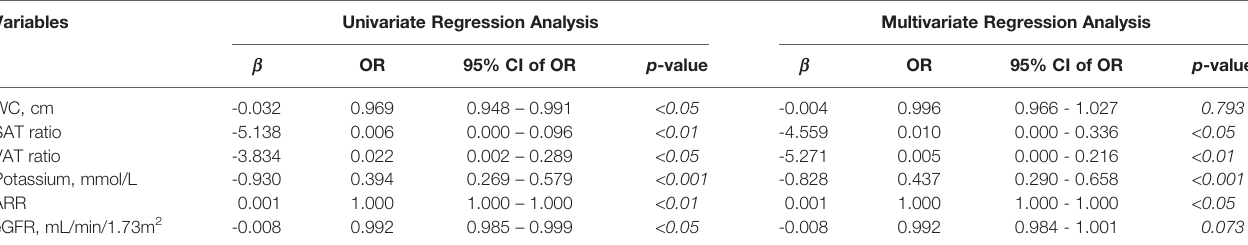
TABLE 3 | Logistic regression analysis of WC, SAT ratio, VAT ratio, potassium concentration, ARR and eGFR between IHA and APA group after propensity score matching for age and BMI. Variables